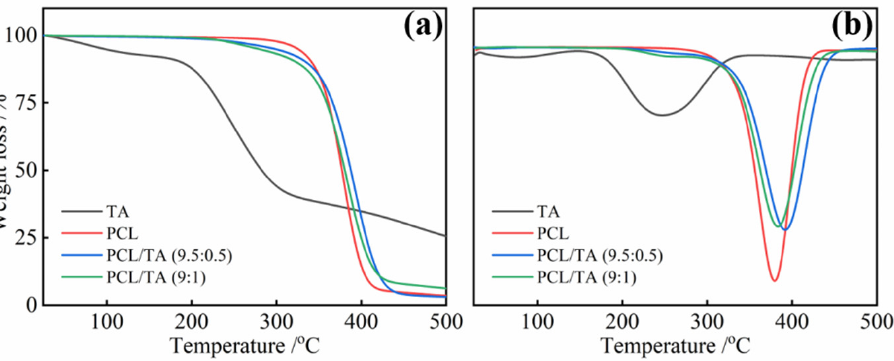
Figure 3. TGA ( a ) and DTG ( b ) of electrospun nanofiber scaffolds spun from PCL from solutions with different PCL/TA weight ratios (9.5:0.5 and 9:1).